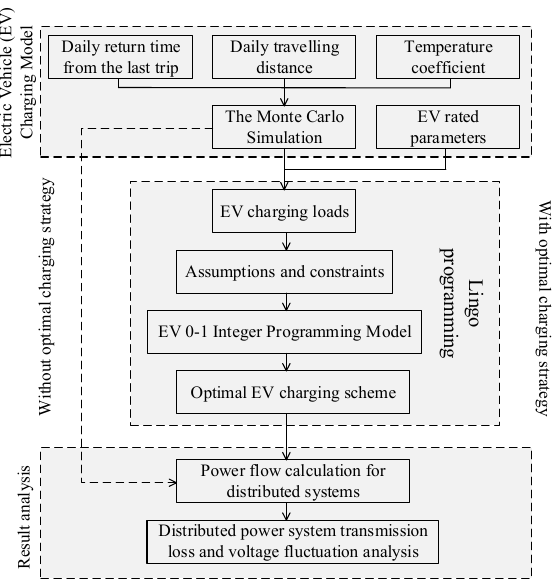
Figure 5. A flow diagram of distributed power system transmission loss optimization based on the electric vehicle 0-1 integer programming model. EV = electric vehicle.